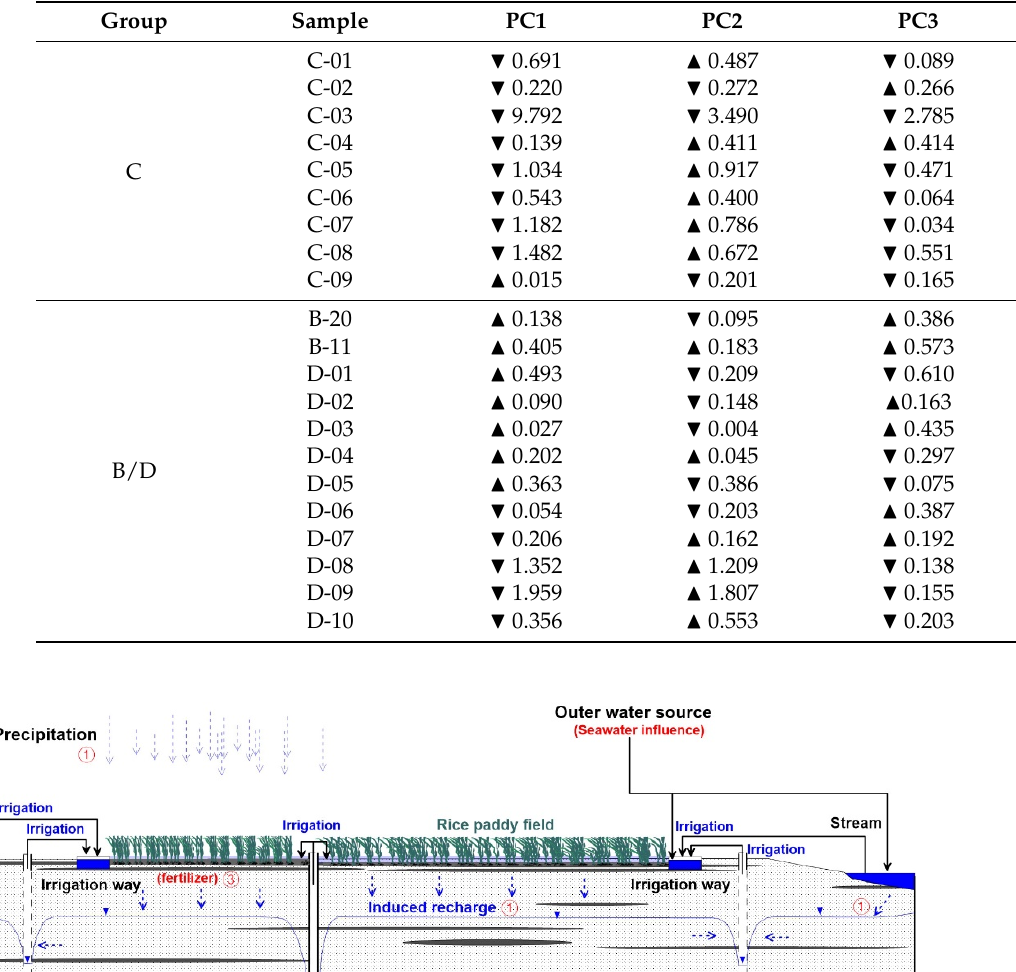
Table 7. Variation of principal components (PCs) during seasonal change. Symbols (cid:78) and (cid:72) indicate increase and decrease of PCs, respectively.